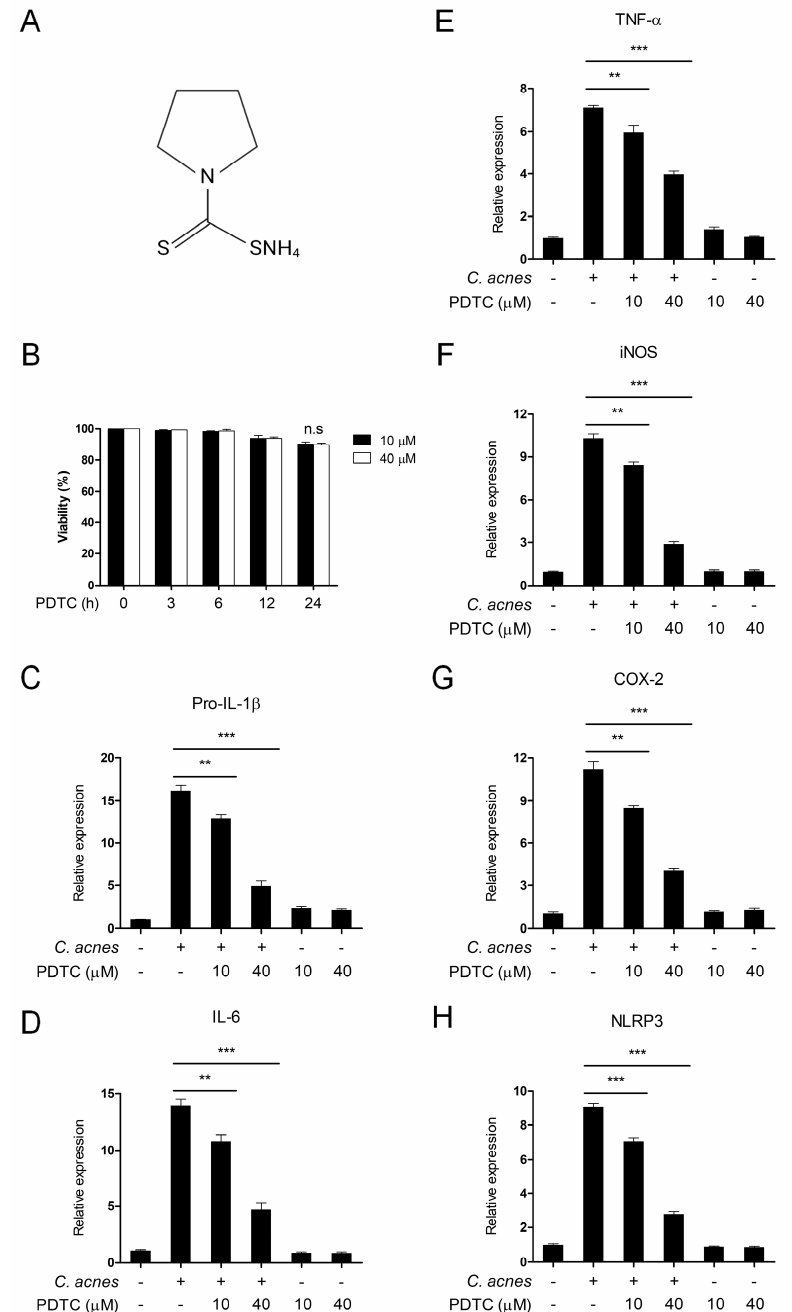
Figure 1. Inhibitory effects of PDTC on the C. acnes -induced inflammatory response. ( A ) Chemical structure of PDTC. ( B ) Mouse BMDMs were treated with 10 µ M PDTC and 40 µ M PDTC for the indicated times. The viability of cells was assessed by MTT assay. ( C – H ) Mouse BMDMs were pretreated with PDTC (10 µ M and 40 µ M) for 30 min and then incubated with heat-killed C. acnes (1 × 10 6 CFU/mL) for 6 h. The mRNA (pro-IL-1 β , IL-6, TNF- α , iNOS, COX-2, and NLRP3) levels were measured using quantitative real-time PCR. The results are represented as the means ± SDs of three independent experiments. n.s, nonsignificant. ** p < 0.01. *** p < 0.001.